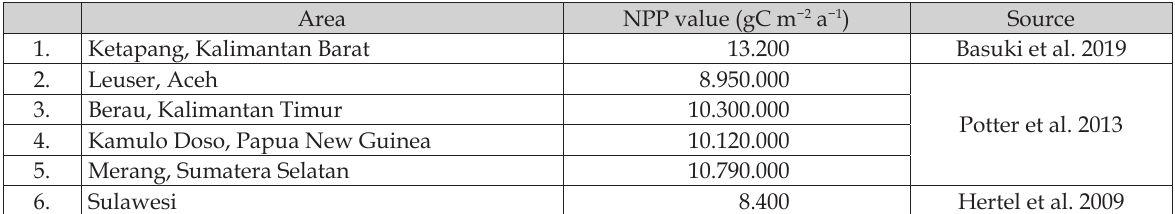
Table 4. Comparison of net primary productivity (NPP) in several tropical climate areas.